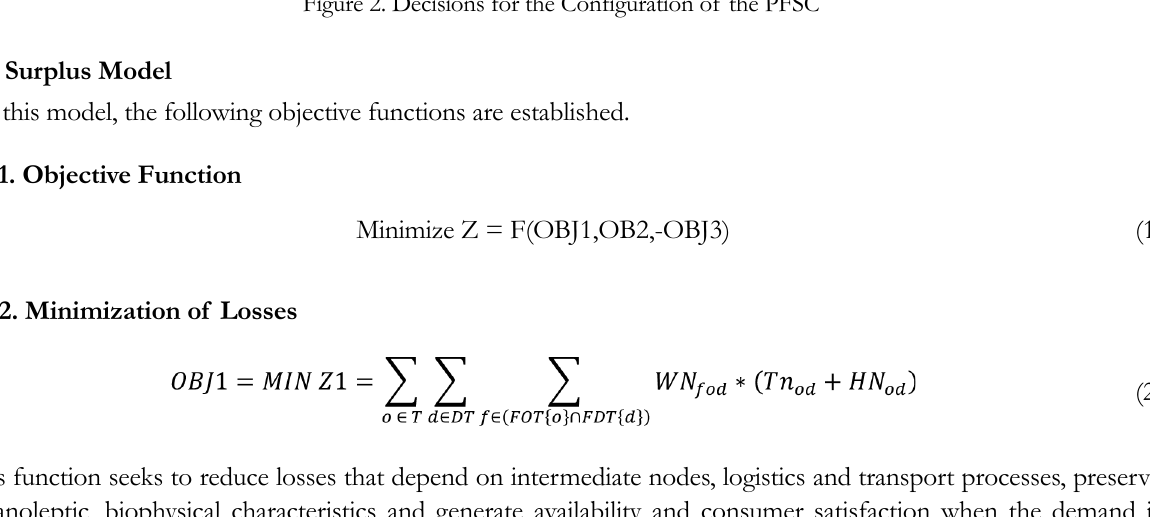
Figure 2. Decisions for the Configuration of the